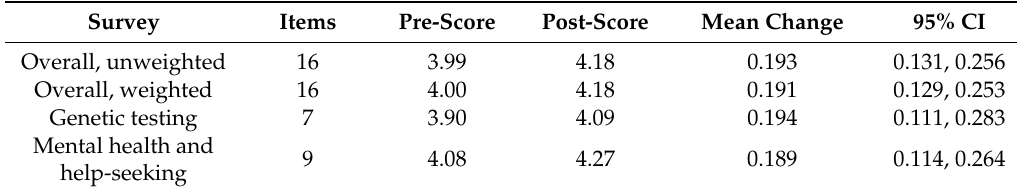
Table 2. Unweighted and Weighted Pre- and Post-Summary Scores Overall and for Genetic Testing, Mental Health and Health-Seeking ( n = 118)